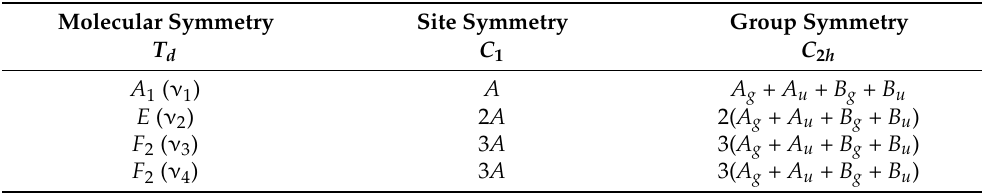
Figure 5. Infrared and Raman spectra of ( a ) [CsEu(H 2 O) 3 (SO 4 ) 2 ]·H 2 O and ( b ) CsEu(SO 4 ) 2 .